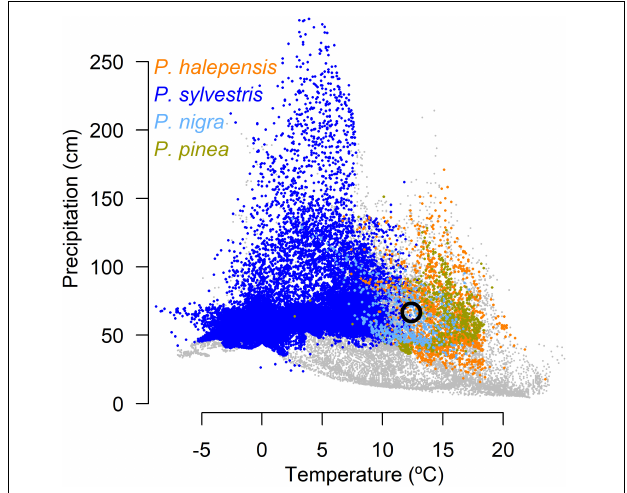
FIGURE 1 | Climate space (Mean annual Temperature–MAT; Total Annual Precipitation–TAP) for each species according to their distribution in Europe. The black circle shows the location of Oristà according to its mean climatic (MAT and TAP) records (AEMET-IMPA,